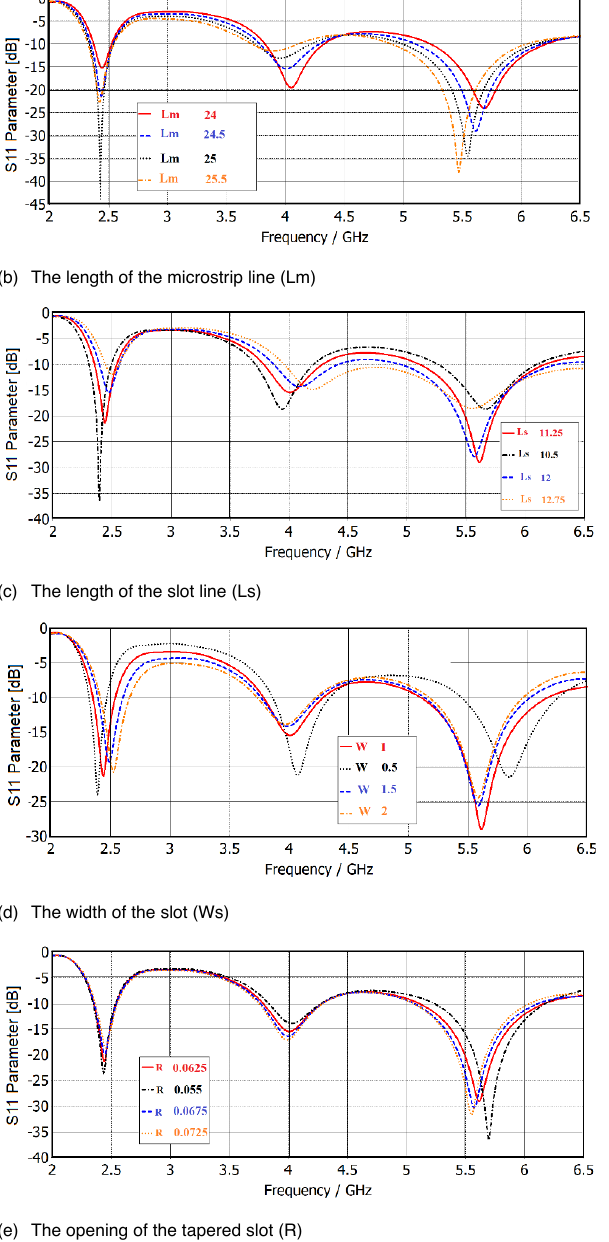
FIGURE 2. Optimizing the antenna dimensions.